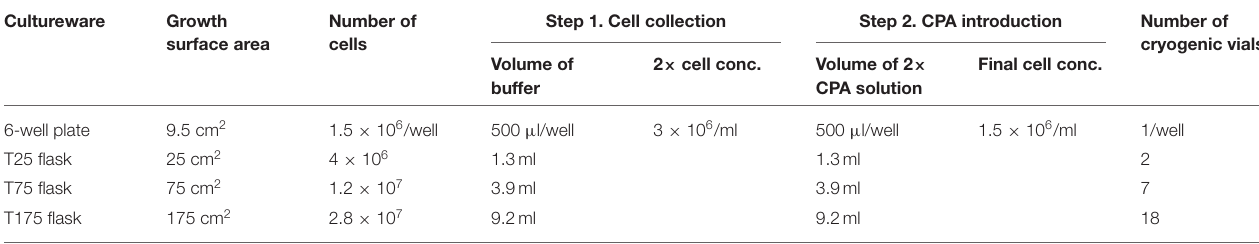
TABLE 1 | Working cell concentration for hiPSC cryopreservation a .